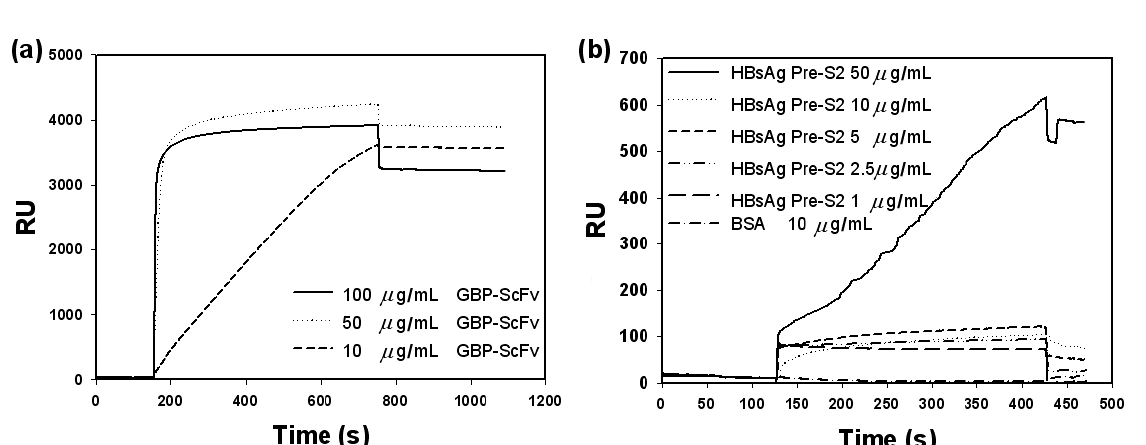
Figure 2. SPR sensorgrams. ( a ) Optimization of the concentration of 6HGBP-ScFv fusion protein. ( b ) SPR detection of target antigen, HBsAg, with 6HGBP-ScFv as a